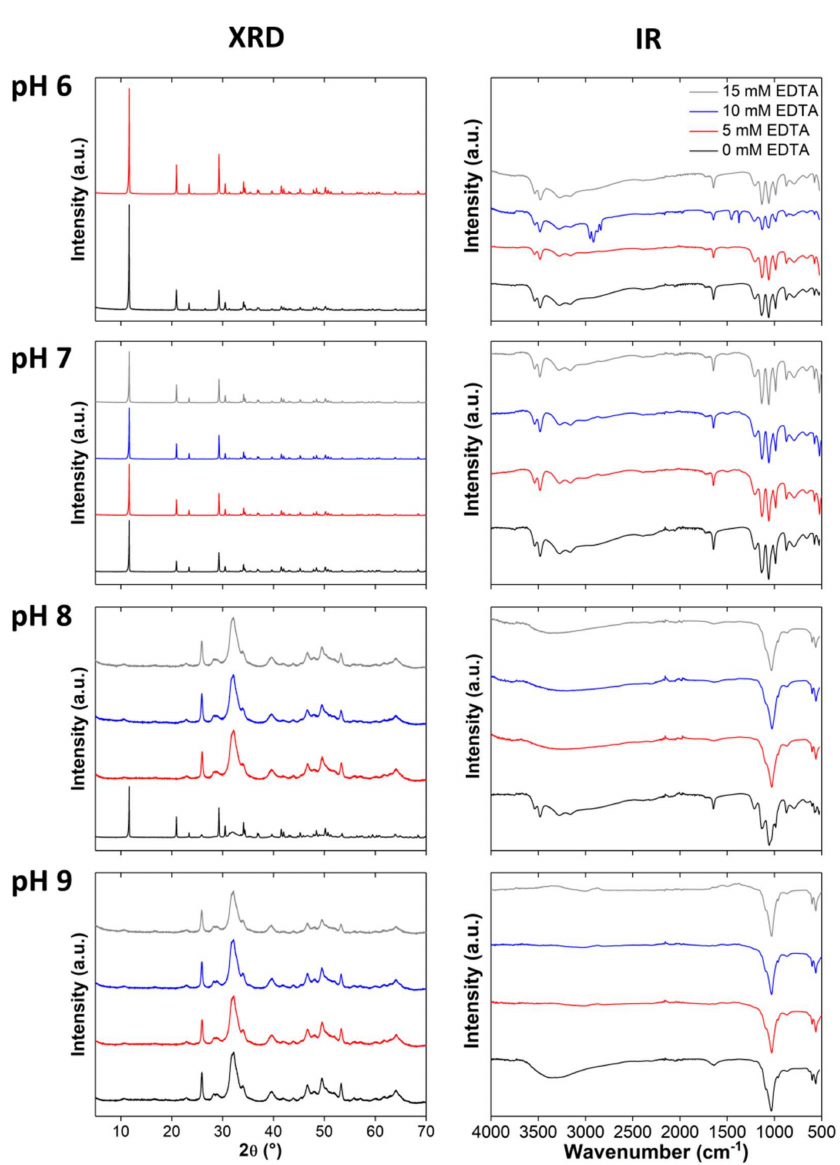
Figure 5. XRD patterns and IR spectra of samples precipitated at different EDTA concentrations (0, 5, 10, 15 mM) and pH (6–9). a.u.: Arbitrary